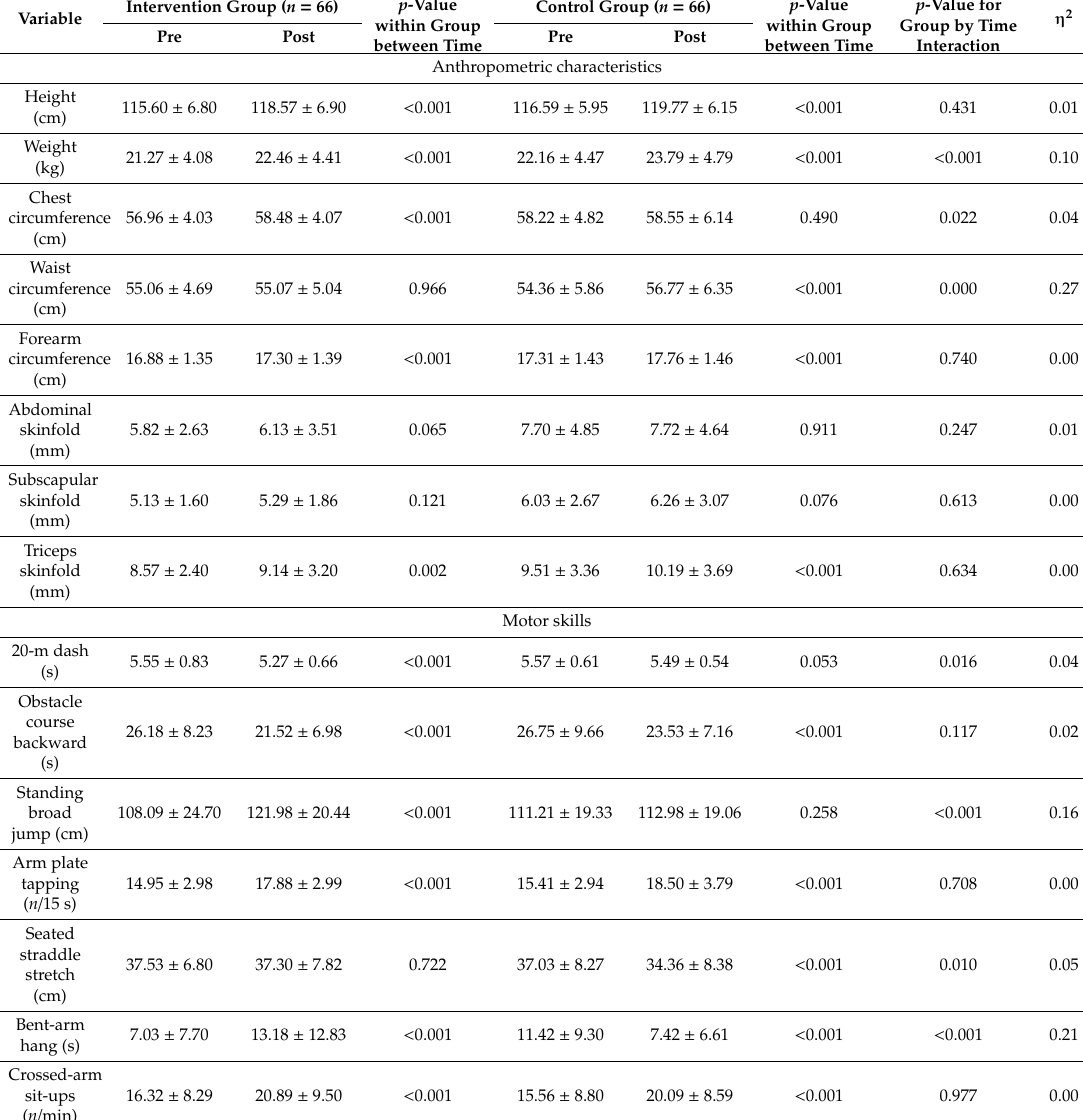
Table 3. E ff ects of 9-month exercise program on anthropometric characteristics and motor skills in preschool